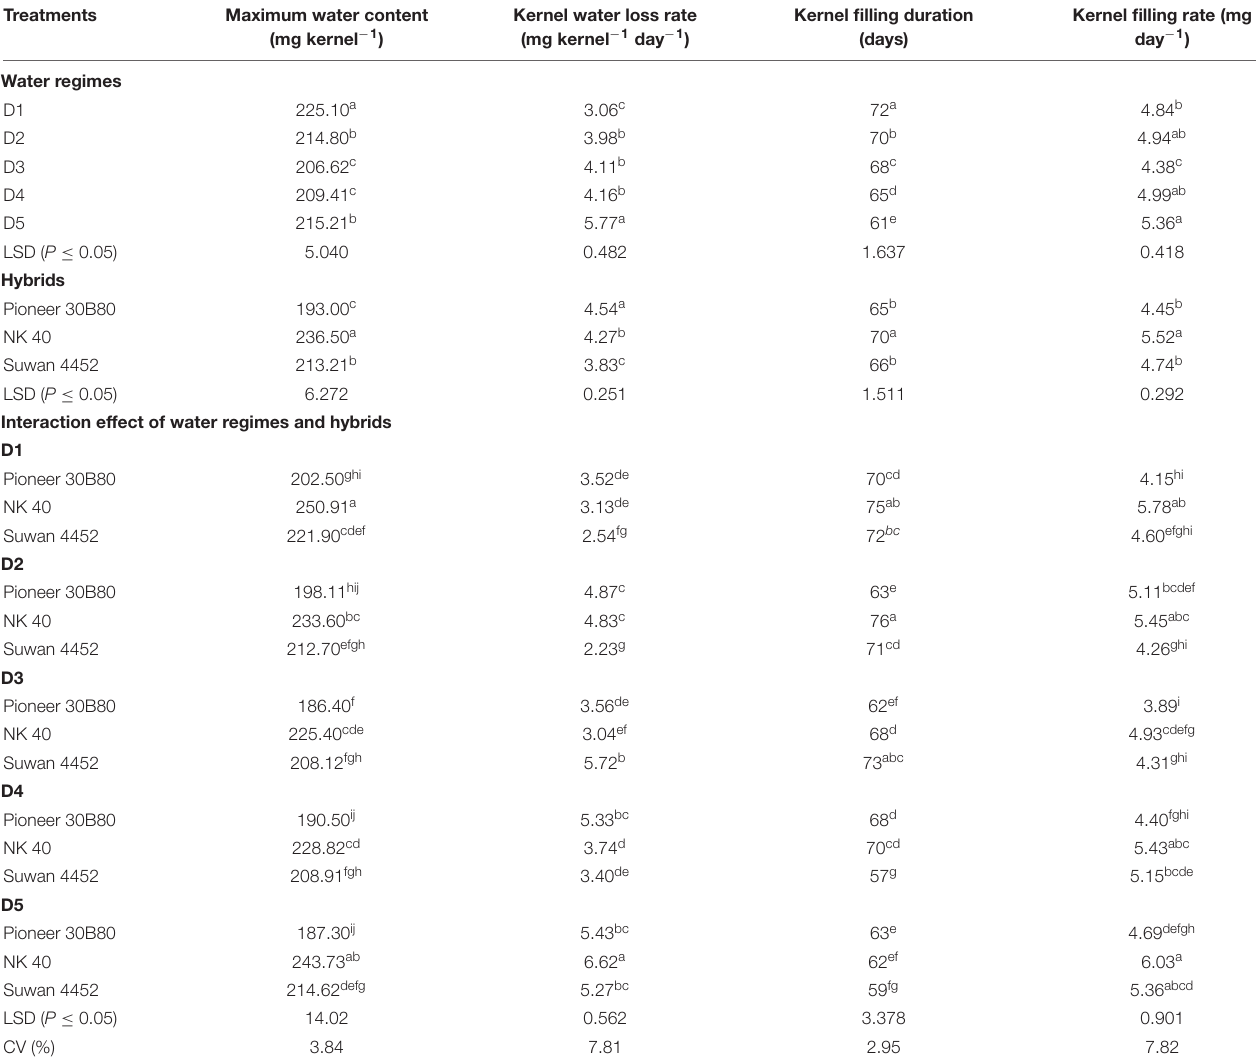
TABLE 2 | Effect of water regimes on kernel filling components of maize hybrids in Expt. 1.